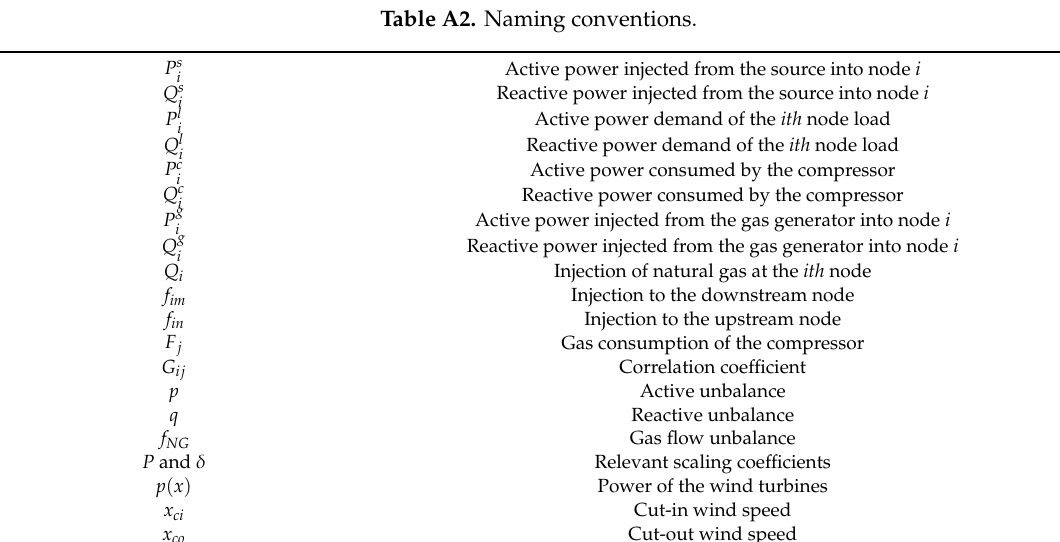
Table A2. Naming